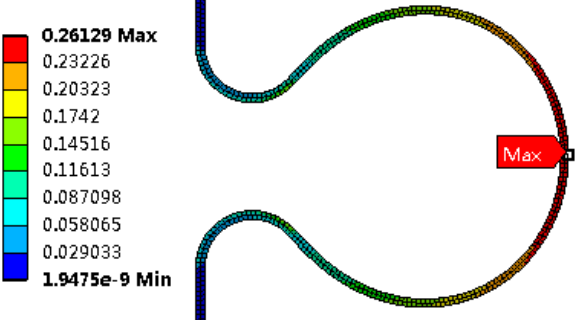
Figure 11. Von Mises strain at the wave after unloading.